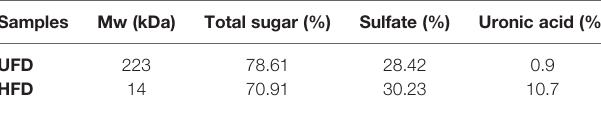
TABLE 1 | The Mw and chemical composition of UFD and HFD.